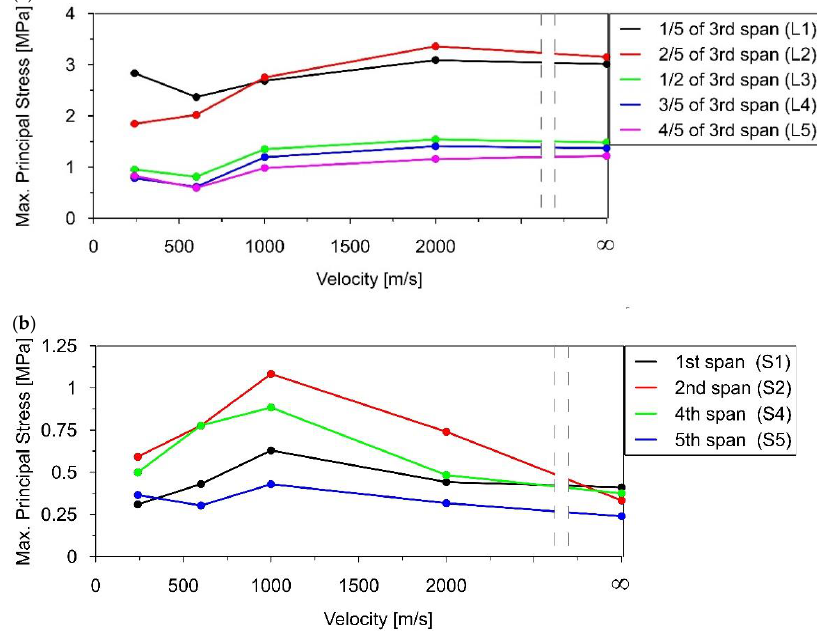
Figure 20. The dependence of maximal principal stresses on the wave propagation velocity for points: ( a ) L1-L5 (on the slender span), ( b ) S1, S2, S4, S5 (in the middle of the stocky spans). Various trends visible in dynamic responses at various points of the bridge should be discussed in-depth in the context of the location of these points on the structure, which seems to be of crucial importance to the obtained results.